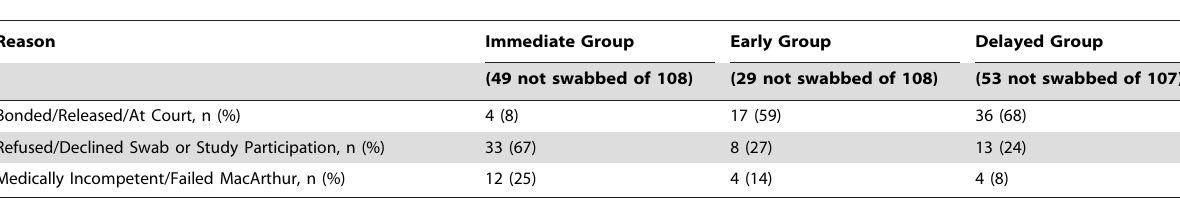
Table 2. Reasons Inmates were not Swabbed for HIV Testing.